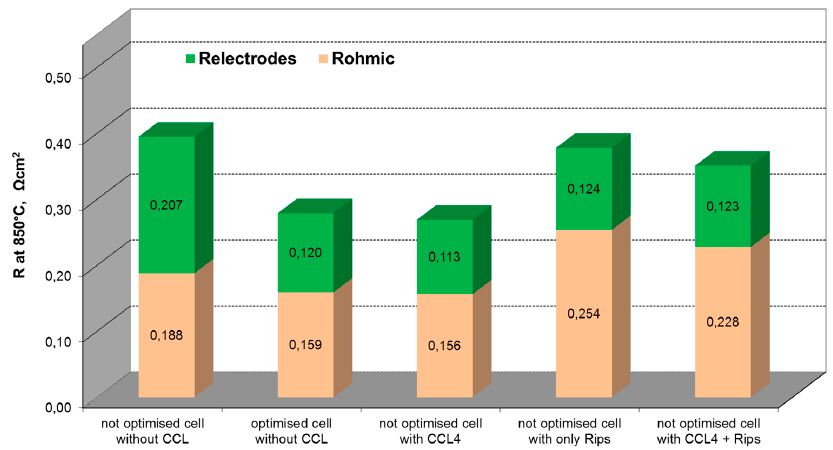
Figure 8. Constituents of ASR obtained by deconvolution of impedance spectra of cells with different CCLs, measured at 850 °C at 300 mA/cm 2 (the ASR of the cells, resulted from impedance spectroscopy, CCLs, measured at 850 ◦ C at 300 mA/cm 2 (the ASR of the cells, resulted from impedance spectroscopy, was not corrected to fuel utilization). was not corrected to fuel